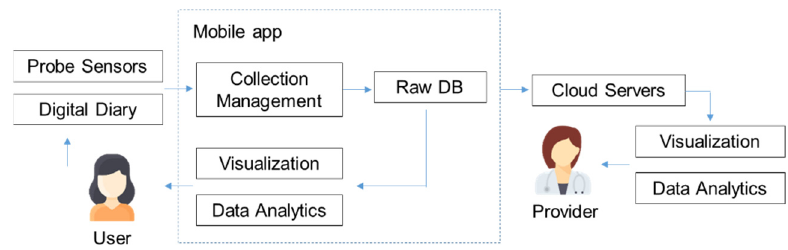
Figure 1. The components of the proposed IoMT.